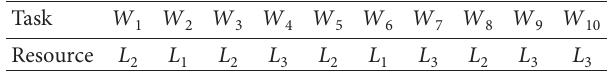
Figure 2: A possible schedule. Table 2: The assignment of a possible schedule.